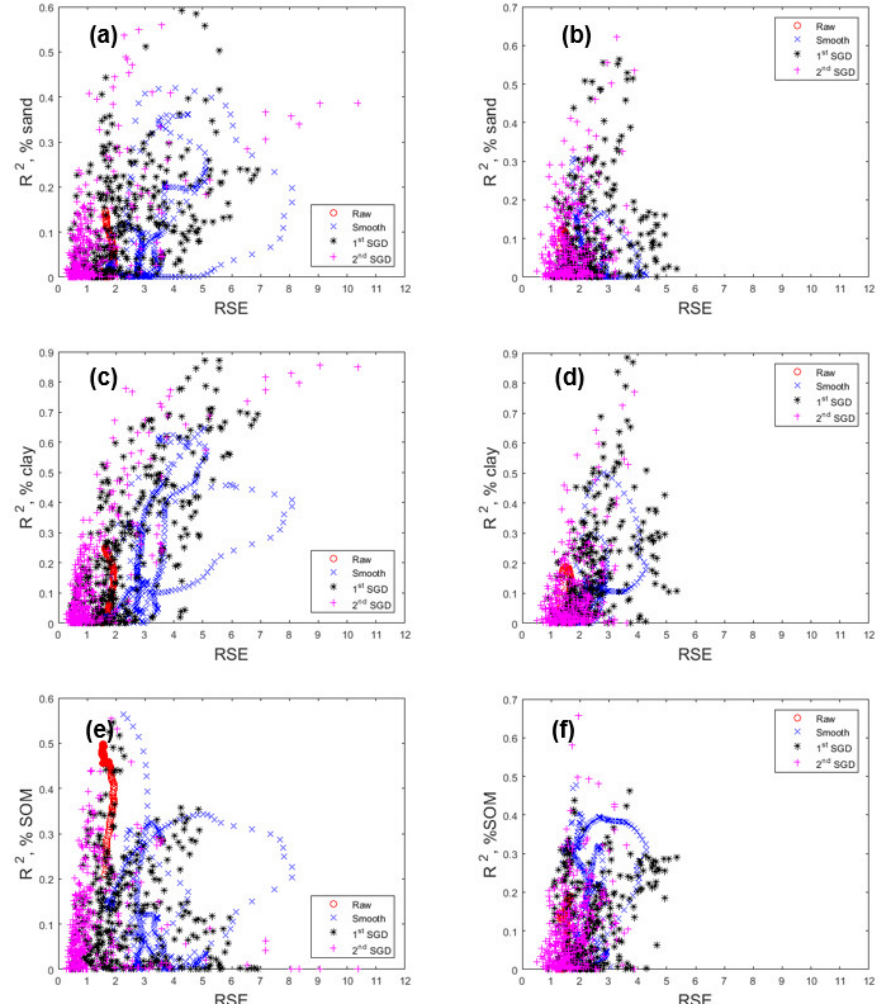
Figure 8. % sand, % clay, and % SOM correlations versus the calculated RSE’s for spectra and its derivatives (ex situ ( a , c , e ) and in situ ( b , d , f